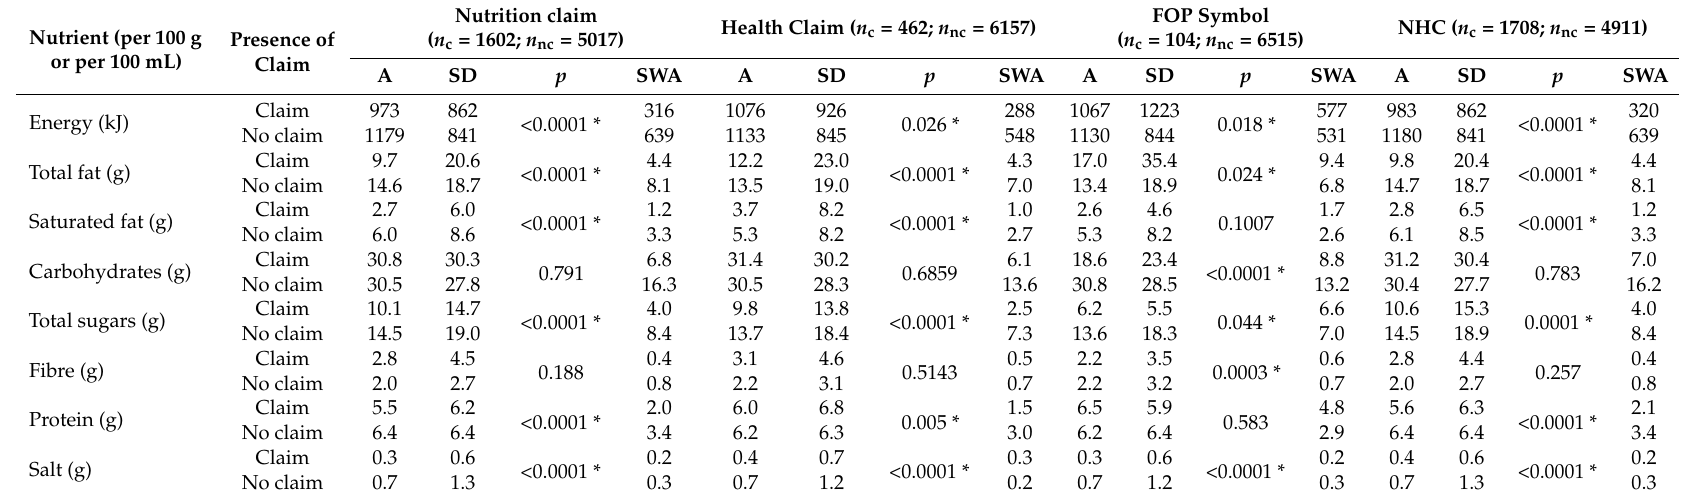
Table 2. Comparison of the nutritional composition of foods and beverages with and without certain type of claims ( n =